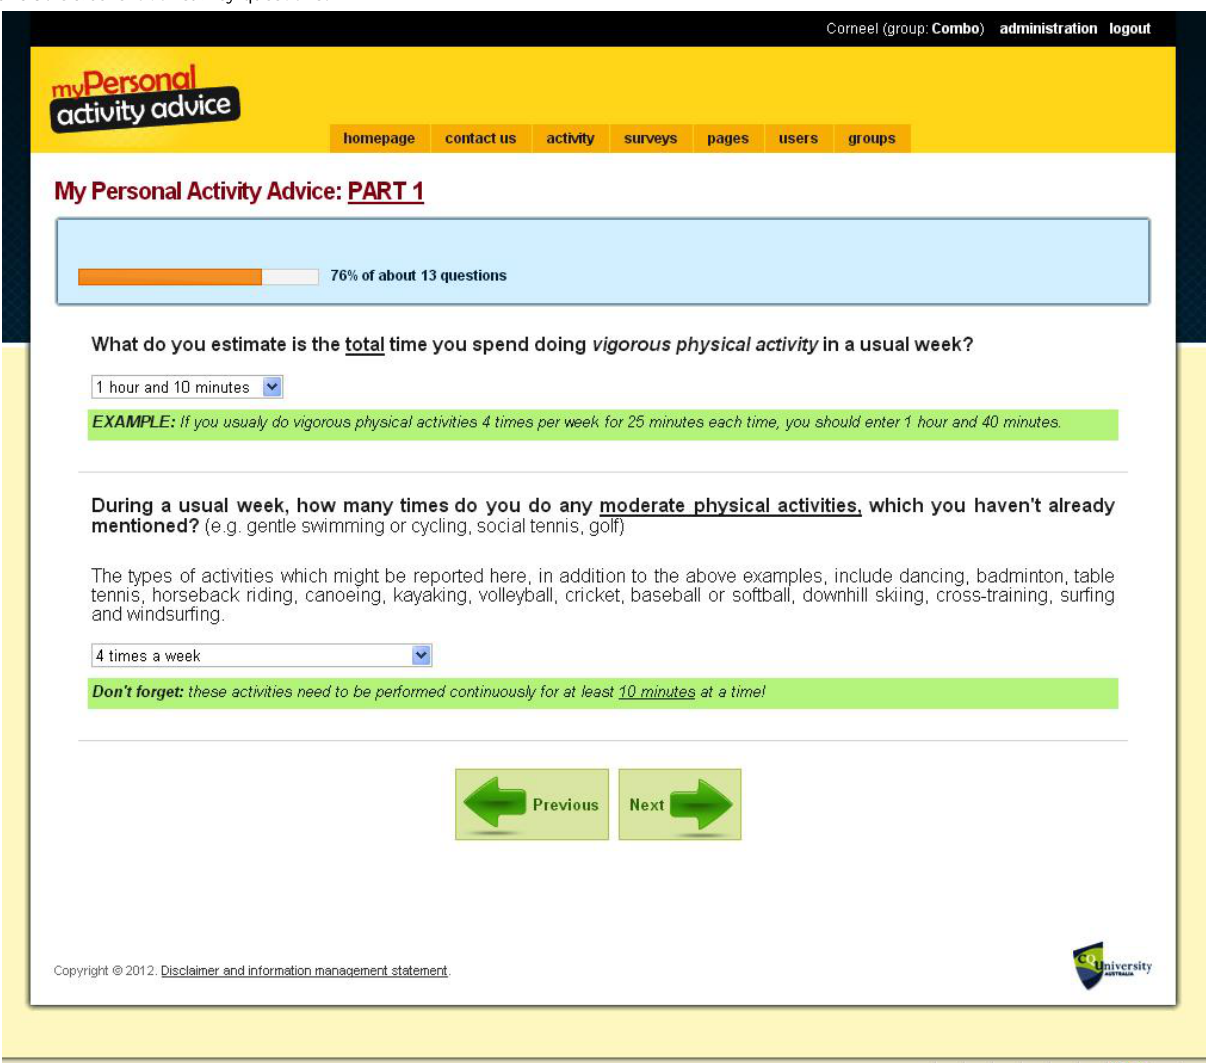
Figure 3. Screenshot of survey